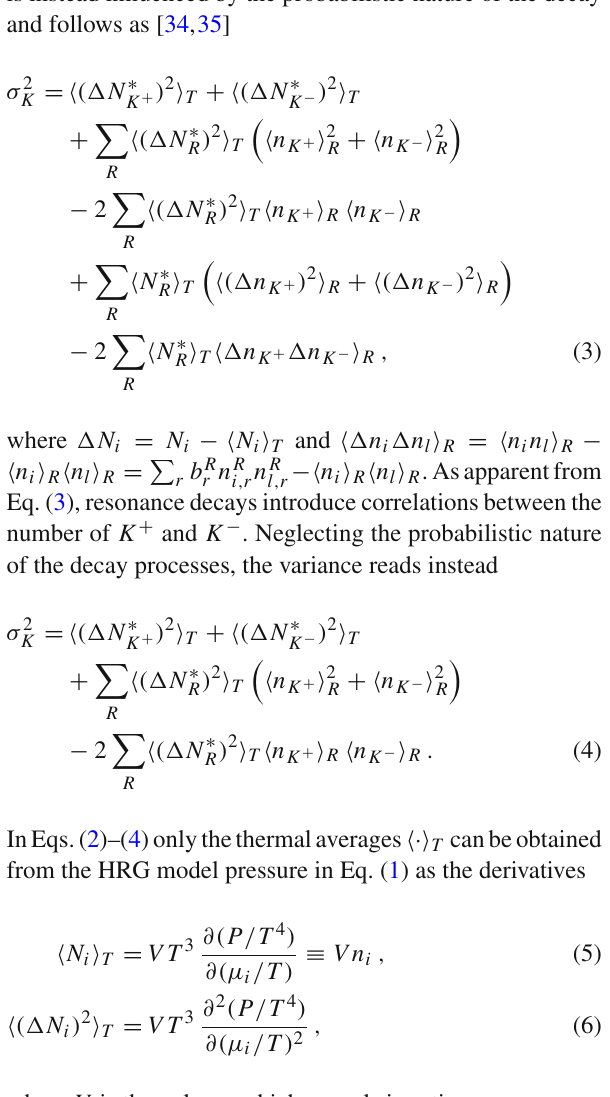
considered rapidity windows in the analysis of ¯ B / B -ratios. The beam energy GeV